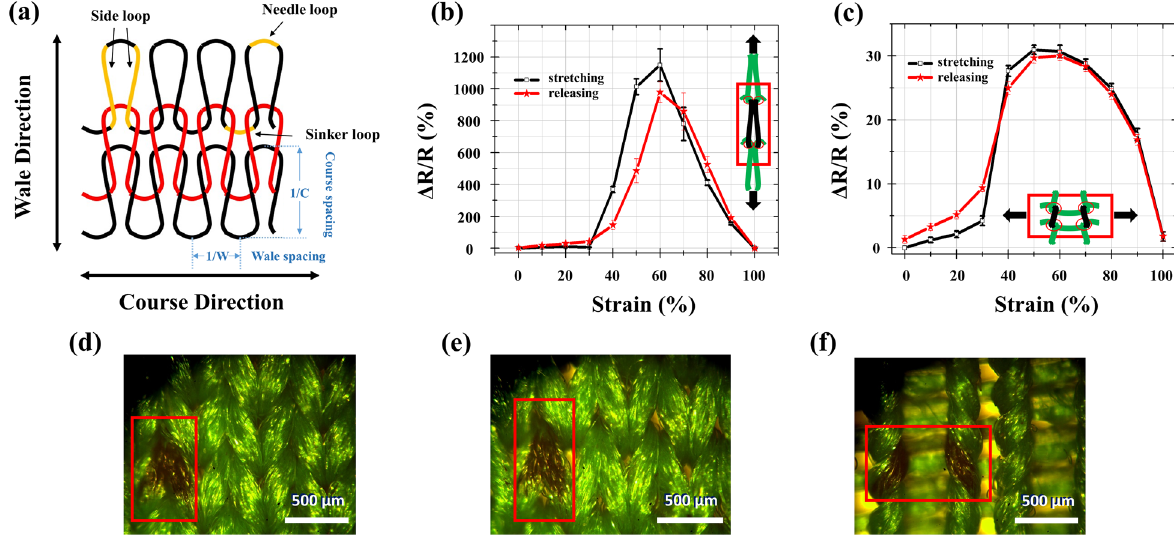
Figure 4. ( a ) Schematic view of a typical weft-knitted textile where the repeated unit cell (RUC) is composed of two side loops, a needle loop, and a sinker loop. ( b ) Relative variation of resistance as a function of the applied strain in the wale direction and in the course direction ( c ). ( d – f ) Optical image of the un-stretched, wale- direction stretched, and course-direction stretched fabrics, respectively. The anisotropic deformation of the RUC is clearly in evidence as depicted in the insets of ( b ) and ( c